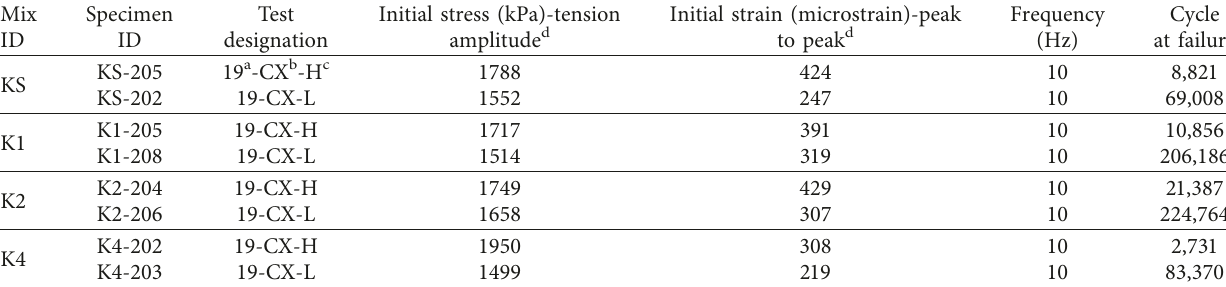
Table 4: Cyclic fatigue test